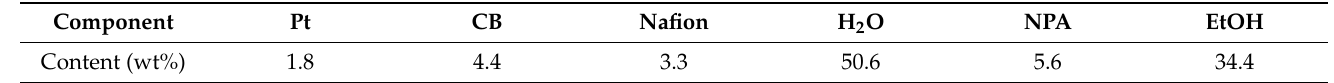
Table 1. Composition of catalyst